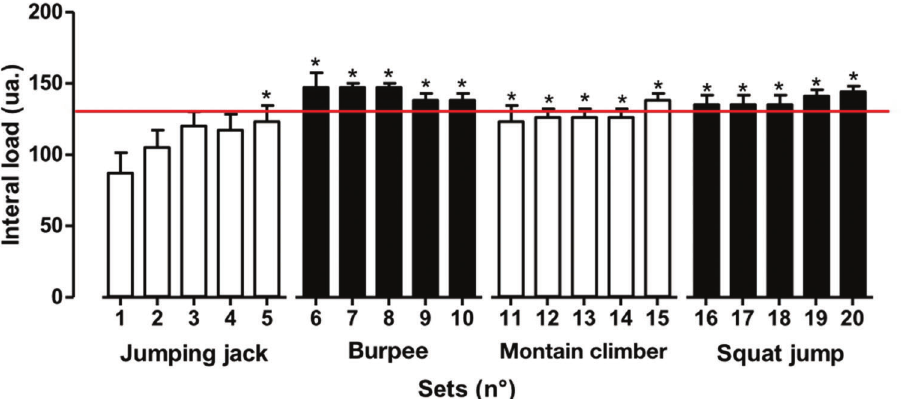
Figure 4 - Values are presented as the means ± standard deviations of the rate of internal load immediately after and before each exercise set. * p o 0.001 vs . the first set.